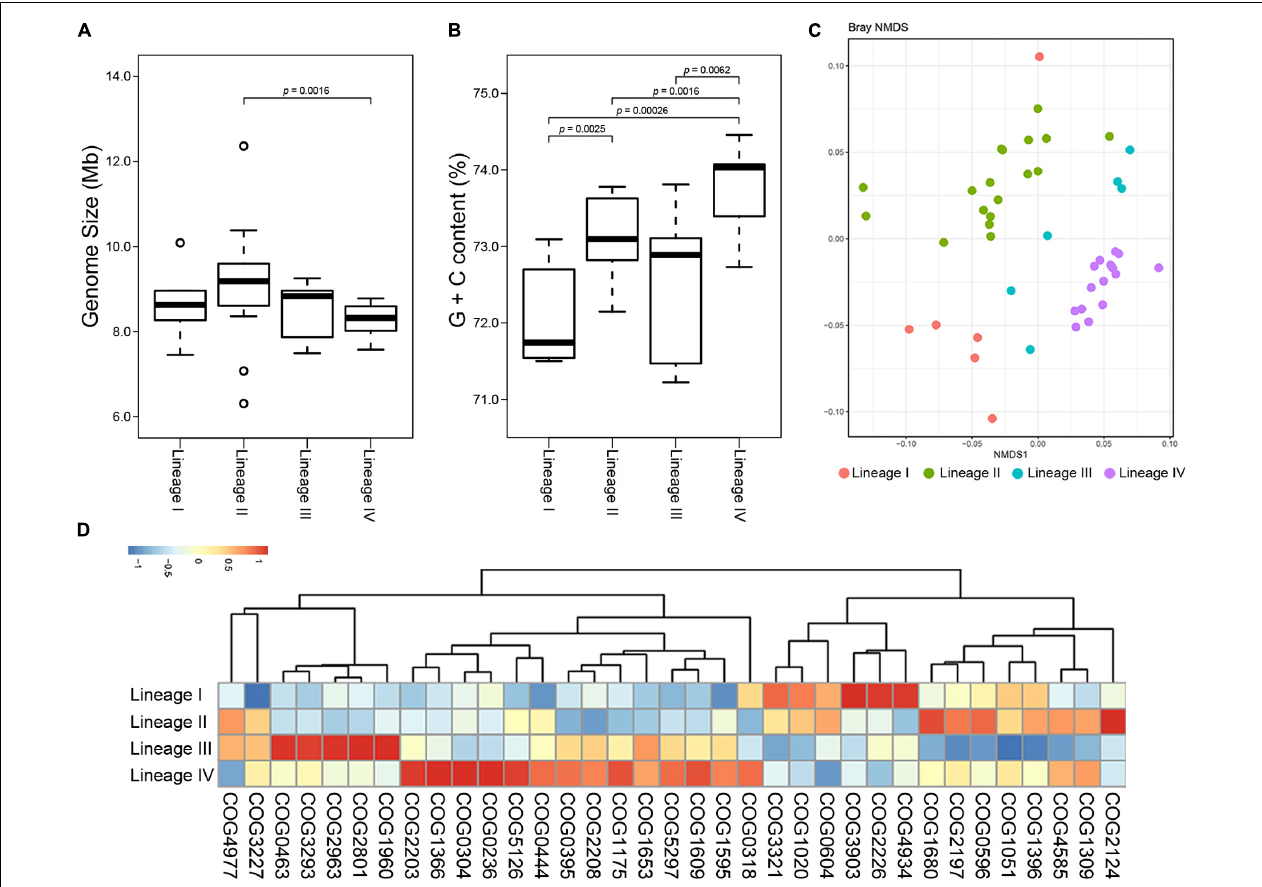
FIGURE 5 | Divergence between lineages of Kitasatospora . Variations in genome size (A) and G + C content (B) between genera in family Streptomycetaceae . The indicated p values were calculated using Wilcoxon test. Only p values less than 0.05 are shown. The boxplot shows the median, and the first and third quartiles as the lower and upper hinges. Outliers are indicated as dots. (C) Non-metric multidimensional scaling (NMDS) plots of COGs showing distinct clustering of lineages within Kitasatospora . (D) Heatmap of COGs that significantly contributed most to the dissimilarity between different lineages within Kitasatospora . Relative abundance of the COGs is presented after transformation with a